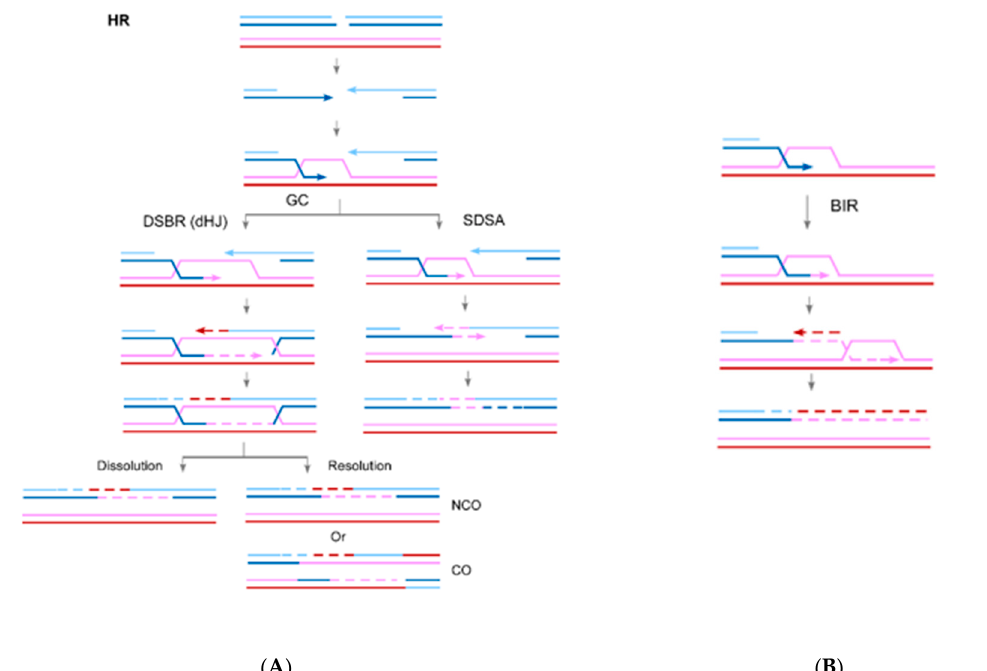
Figure 1. Pathways of homologous recombination (HR). Gene conversion (GC) is used when both sides of a DSB contain homology to the donor ( A ). GC can occur in the forms of synthesis ‐ dependent strand annealing (SDSA) or double ‐ strand break repair (DSBR) (also called the double Holliday junction repair: dHJ repair). Double Holliday junctions can be resolved by dissolution to give non ‐ crossover (NCO) products, or by resolution to produce NCO and crossover (CO) products. When only one DSB end has homology to the donor template, break ‐ induced replication (BIR) is used ( B ).